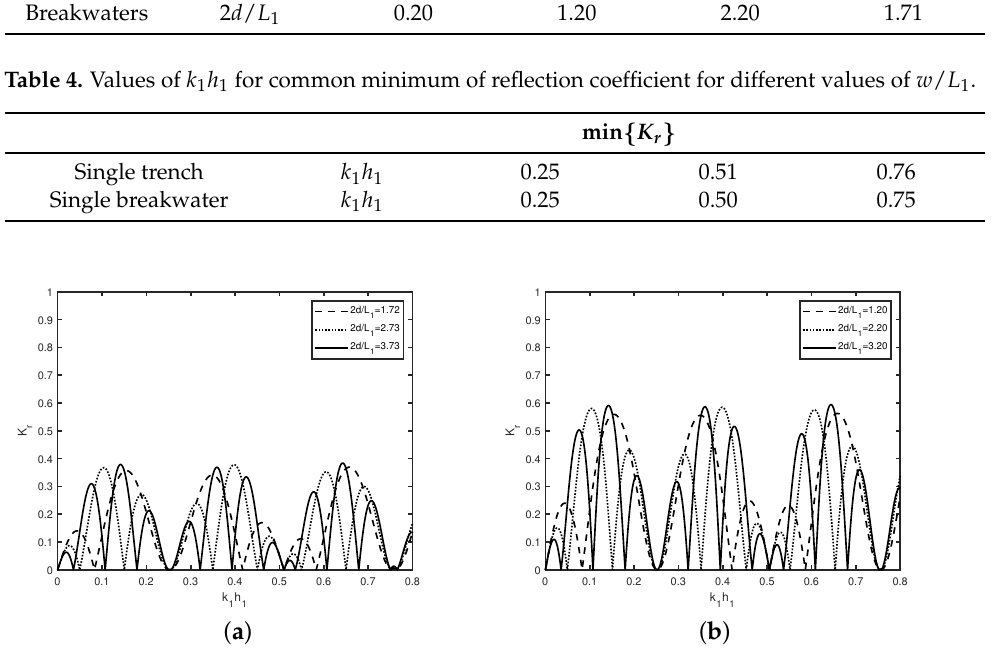
Figure 7. K r versus k 1 h 1 in case of double rectangular ( a ) trench width w / L 1 = 0.6; ( b ) breakwater with width w / L 1 = 0.35 in the absence of the semi-infinite plate for different values of gaps 2 d / L 1 . In Figure 8, the reflection coefficient K r is plotted against wavenumber k 1 h 1 for dif- ferent number N of rectangular (Figure 8a) trenches with width w / L 1 = 0.6, d / L 1 = 0.86 and (Figure 8b) breakwaters with w / L 1 = 0.35, d / L 1 = 0.60 in the absence of semi- infinite plate. Figure 8a reveals that three full cycles are completed in case of trenches at k 1 h 1 = 0.25, 0.5, 0.75, whereas, in Figure 8b, in case of breakwaters, three full cycles